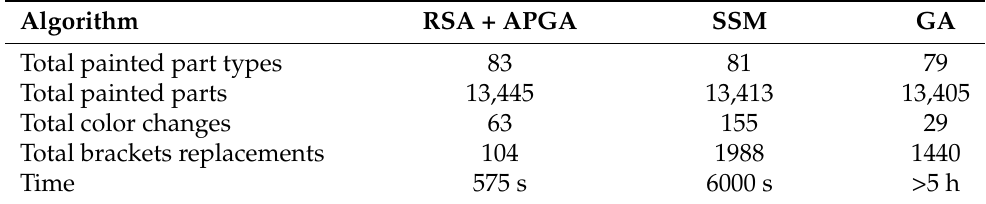
Table 5. Results of maximizing production and minimizing the number of bracket